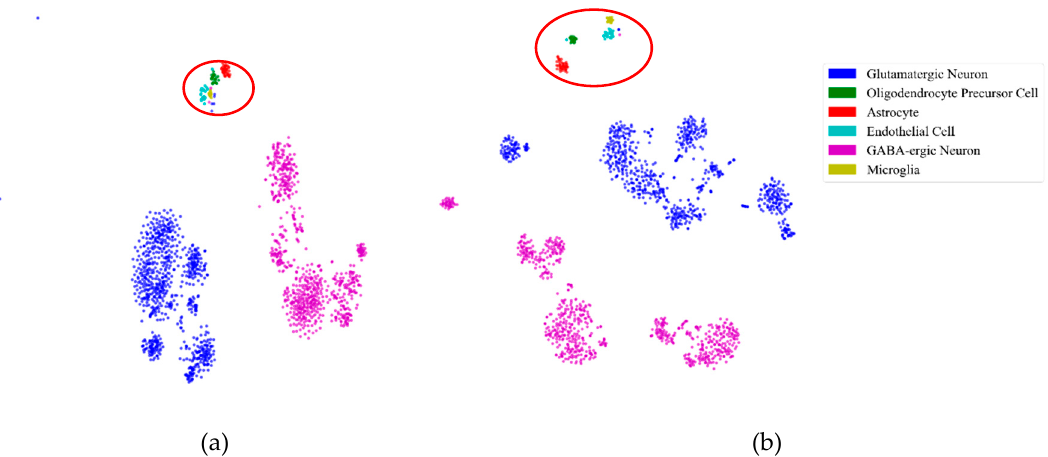
Figure 8. Effectiveness of feature extraction on mouse visual cortex data. ( a ) The t -SNE graph of mouse visual cortex data of 500 genes with NFE. ( b ) The t -SNE graph of the mouse visual cortex data of 500 genes with PCA. The read oval circled different clustering results of 500 genes with NFE and PCA.